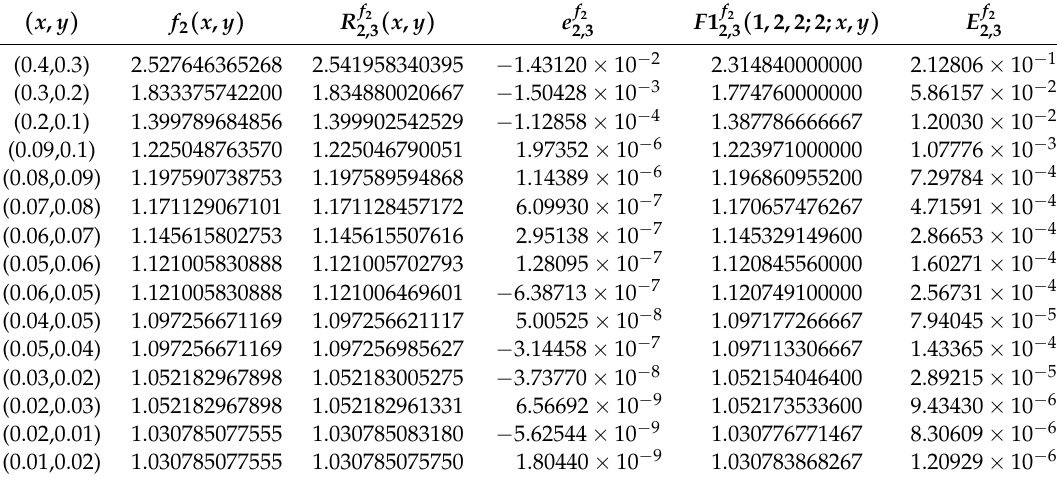
( x , y ) and F 1 f 2 ( 1,2,2;2; x , y ) 2,3 2,3